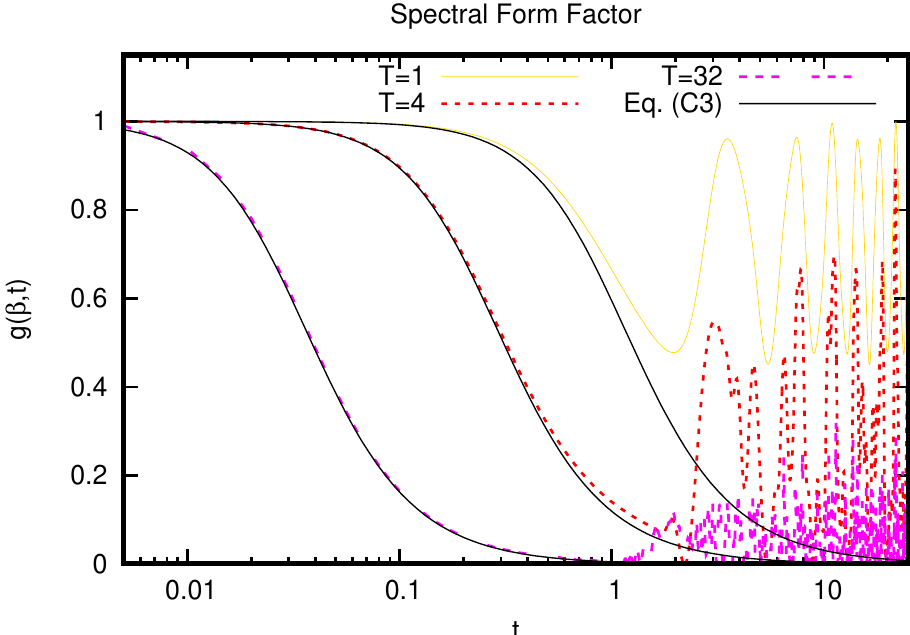
Figure 4 . Spectral form factor g ( β, t ) , normalized to g ( β, 0) = 1 as a function of time for three different temperatures T = 1 , 4 , 32 . For high temperatures, the behavior of the spectral form factor is very much reminiscent of that from random matrices, cf. ref. [5]. For comparison, the analytic high-temperature limit of the form factor (C.3) is also